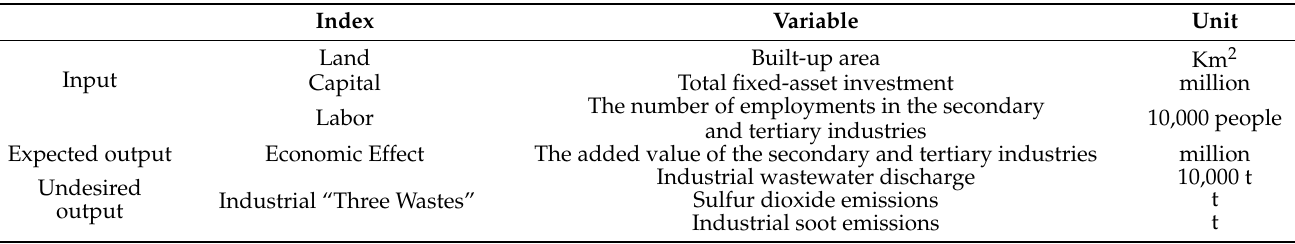
Table 1. Quantitative indicators of